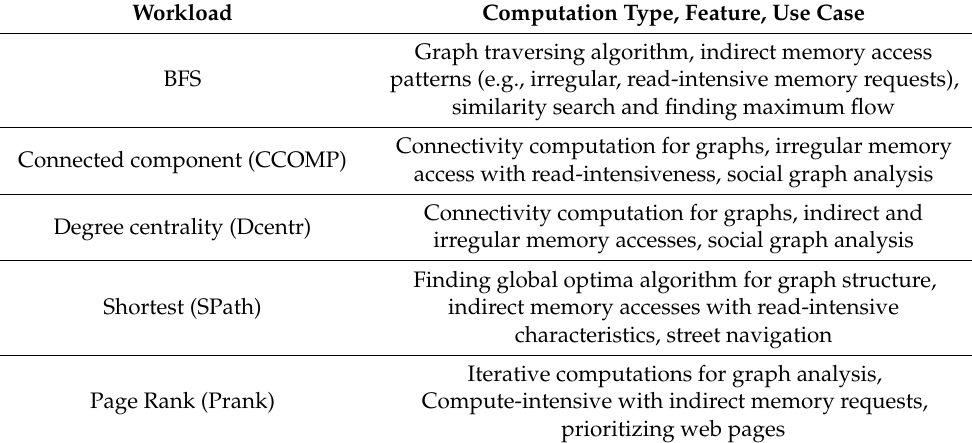
Table 2. Workloads of Graph